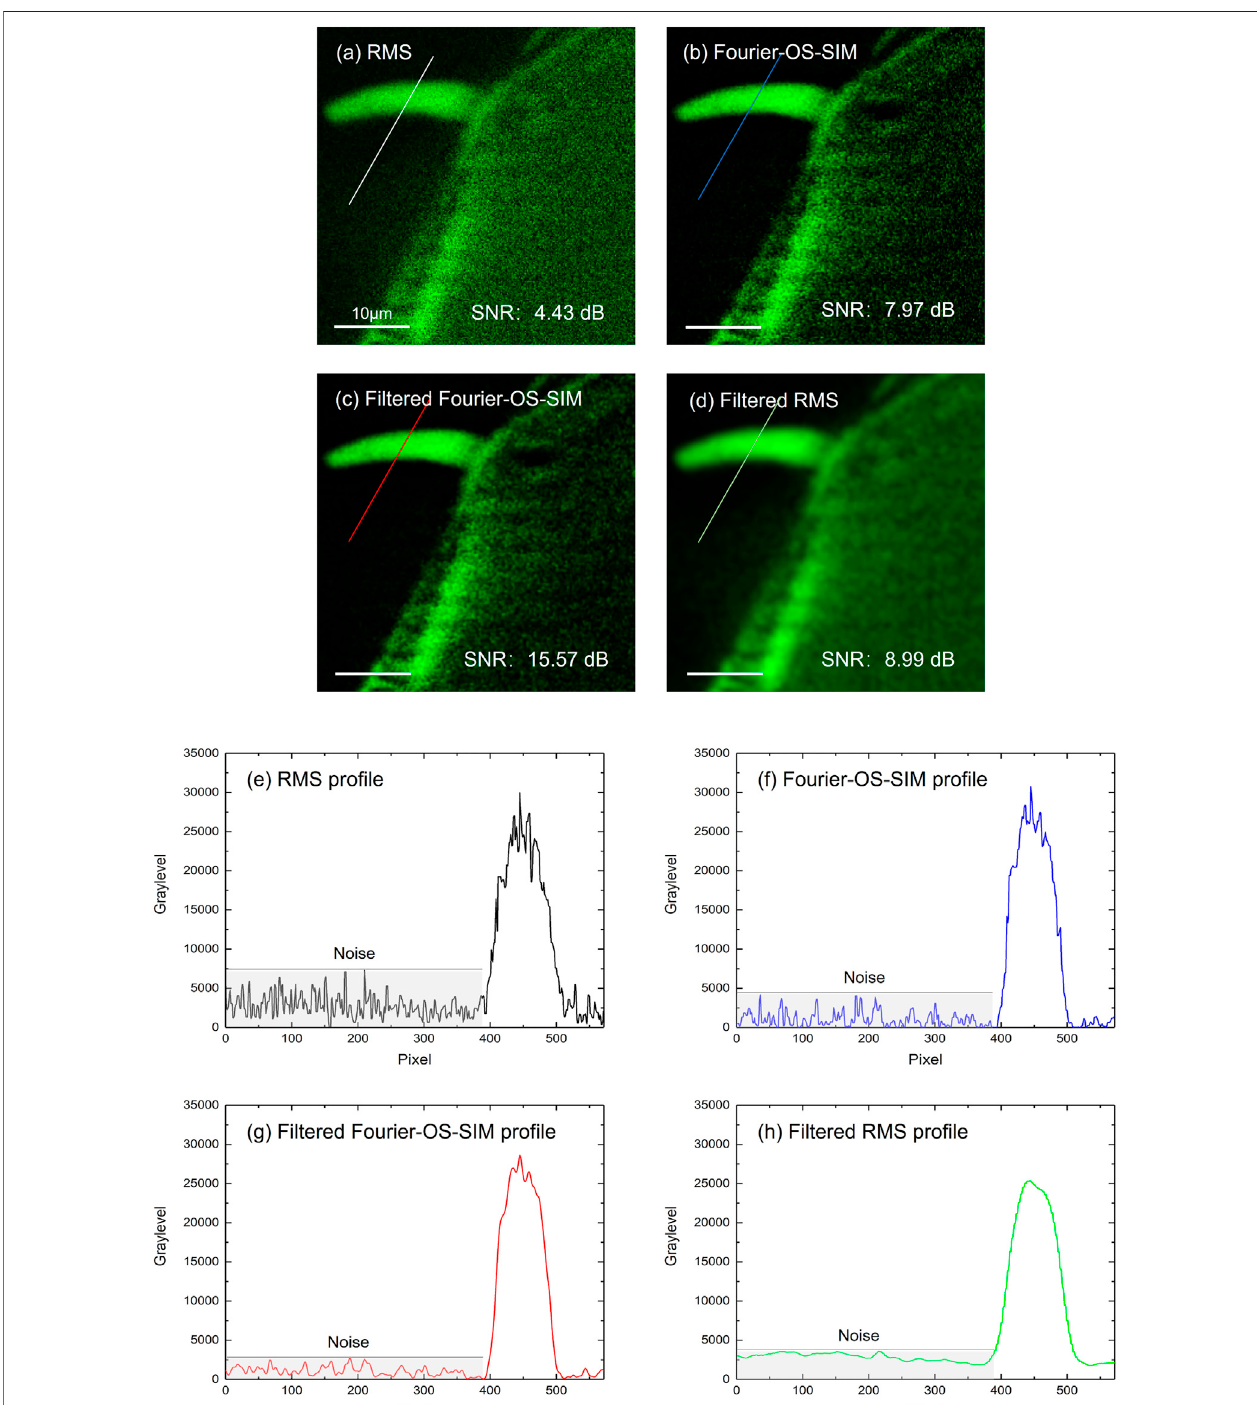
FIGURE 3 | Fourier-OS-SIM images before and after Gaussian low-pass fi ltering compared to the RMS image. (A – D) : images of the RMS, Fourier-OS-SIM before and after fi ltering, and the fi ltered RMS, respectively. (E – H) : the intensity pro fi les along the marked lines in (A – D) .